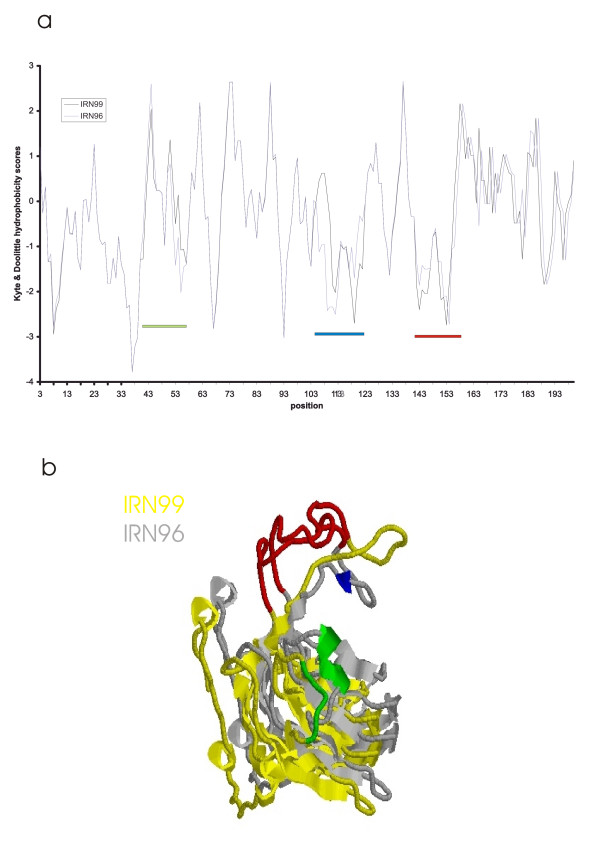
Amino Acid Hydrophobicity plot (a) and structural alignment (b) based on the consensus sequences of the both serotype A lineages IRN99 andIRN96. Significant differences are indicated by coloured bar, where the colour refers to the part of the structural model.